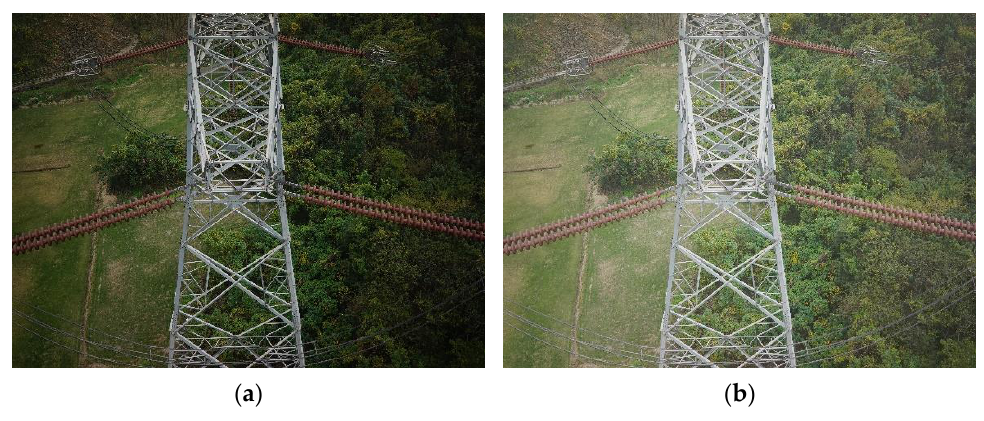
Figure 7. ( a ) Original image; ( b ) gamma transform.